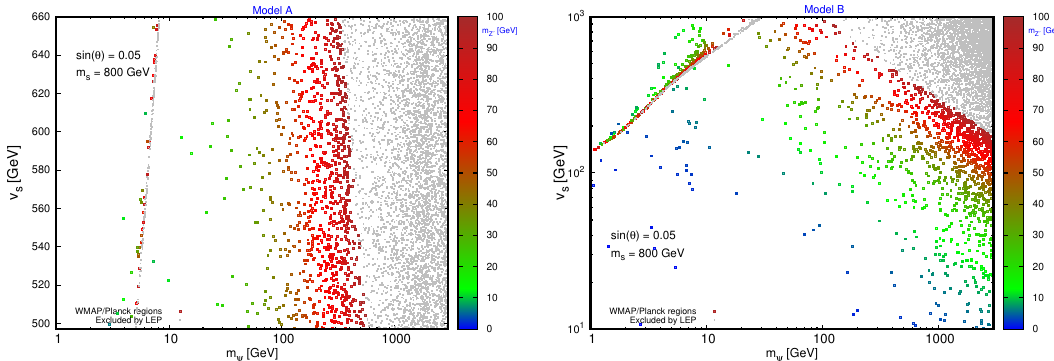
Figure 3 . Comparing the viable region for the DM mass, m , and m Z 0 against the v s for left) model A and right) model B . The gray region is excluded by the LEP. The muon anomaly is applied in the model A by taking 497 GeV < v s < 659 GeV in the scan. The other parameters in the scan are 1 GeV < m < 3 TeV and 10 (cid:0) 3 < g 0 < 1. The singlet scalar mass is (cid:12)xed at m s = 800